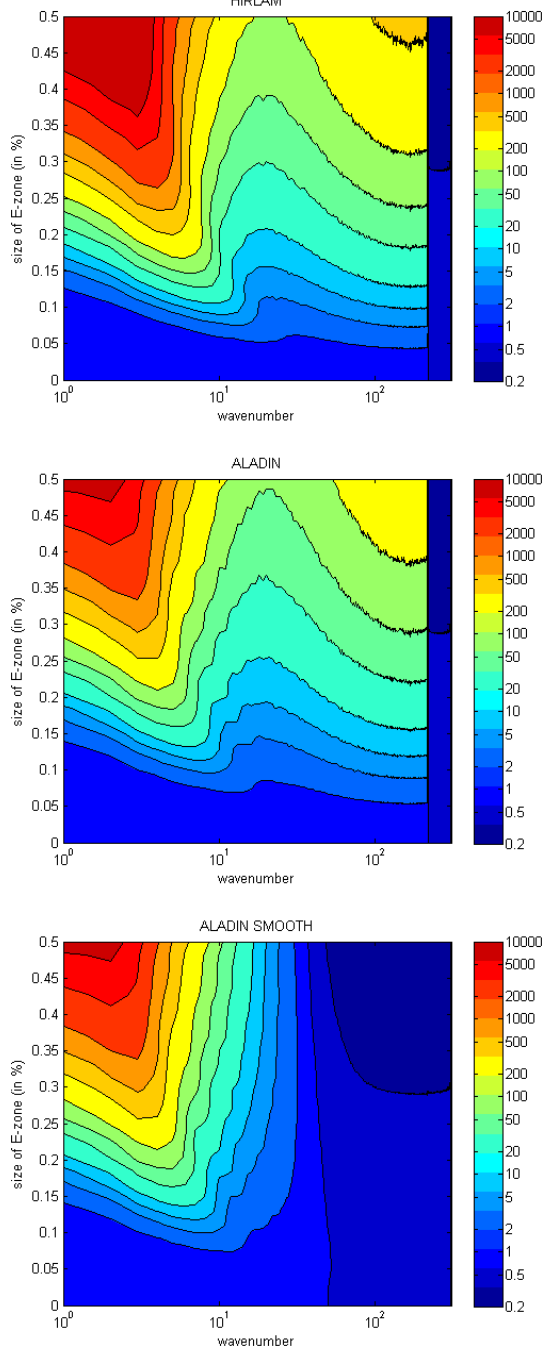
Figure 9. The ratio between the periodized spectrum and the orig- inal k − 5 / 3 spectrum for several widths of the extension zone for HIRLAM (top), ALADIN (middle) and ALADIN SMOOTH (bot- tom) methods. The ratio between the size of the extension zone and the full domain is shown on y axis.